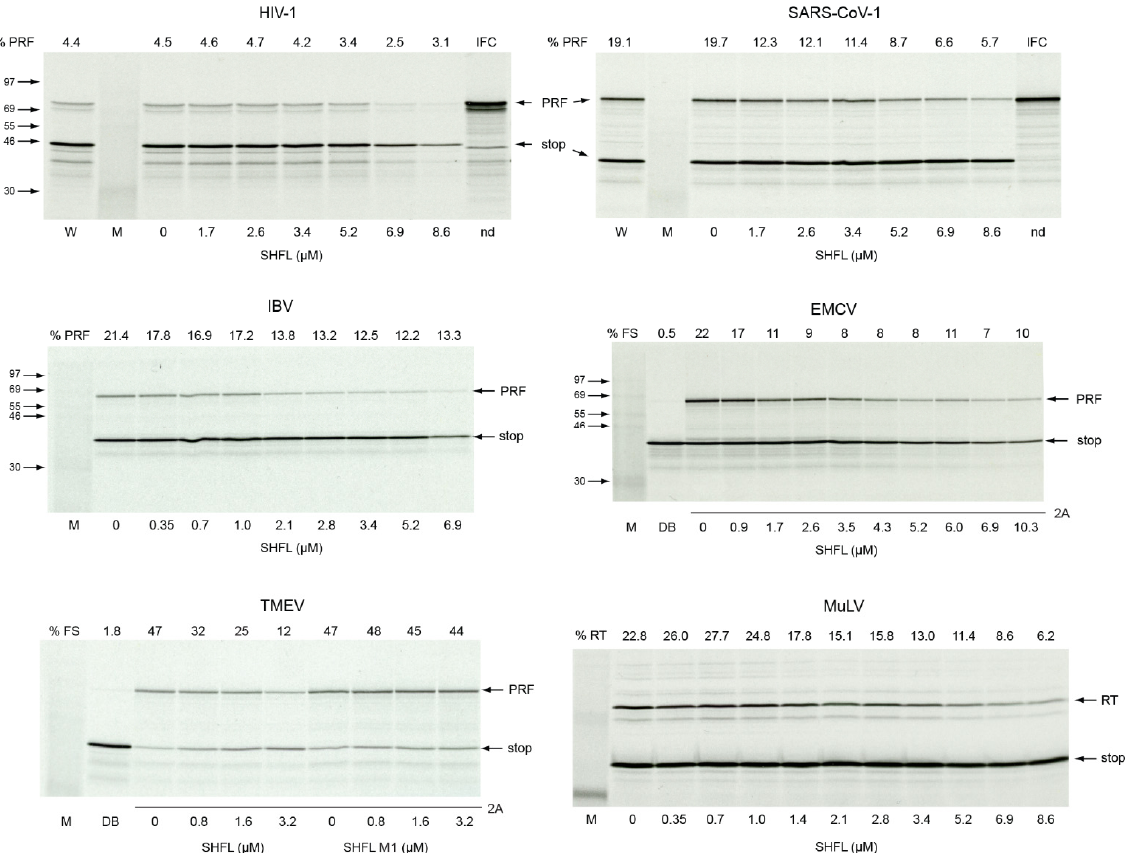
Figure 3. Inhibition by SHFL of PRF and RT in vitro . RNAs derived from recoding reporter plasmids were translated in RRL in the presence of the indicated concentration of His-tagged SHFL or SHFL-M1. The addition of only water (W) or SHFL dilution buffer (DB) is also indicated. The products were resolved by 12% SDS-PAGE and visualized by autoradiography. 14 C molecular size markers were also run on the gel (M). IFC represents an in-frame control translation of an mRNA in which the two reading frames are placed in-frame by the addition of a single nucleotide immediately downstream of the slippery sequence (see Table 1). Proteins generated by ribosomes that do not frameshift (stop) or that enter the − 1 reading frame (PRF), or read through a stop codon (RT) are arrowed. In the EMCV and TMEV panels, the addition of the trans -activator protein 2A is shown by lane underlining.